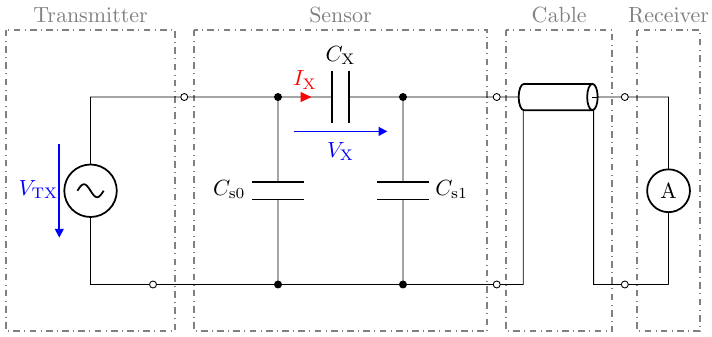
Figure 3. Simplified circuit representation of a capacitive measurement device. For low-Z measure- ments, a current measurement is used